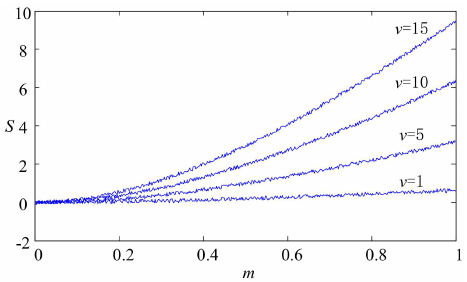
Figure 3. Image of S function when v = 1, 5, 10, 15.